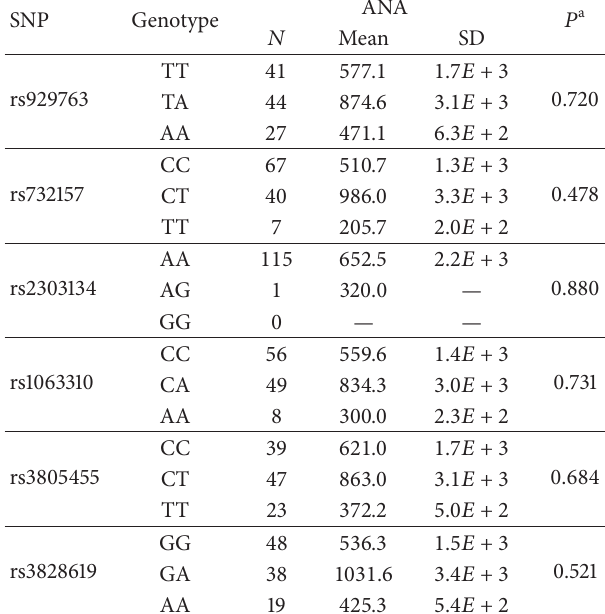
Table 6: The levels of ANA among the genotypes of polymorphisms of GABRP gene in SLE